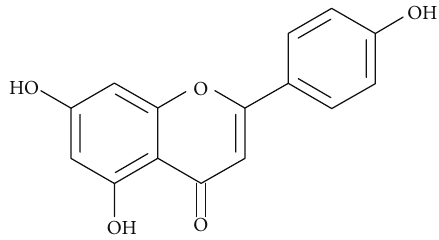
Figure 1: The chemical structure of the